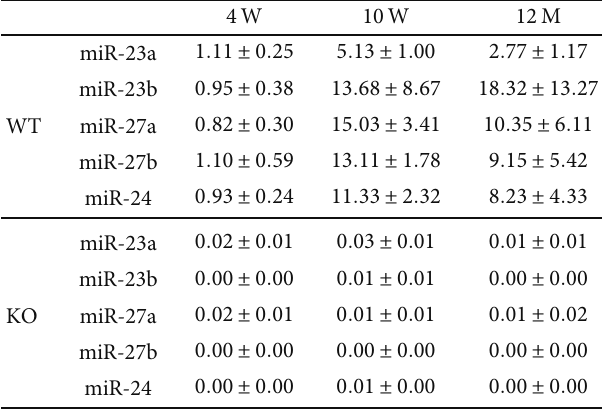
Mean values ± SD of relative expressions to the expressions in a 4-week-old wild-type mouse. Wild-type (WT) mice and miR-23-27-24 cluster knockout (KO)